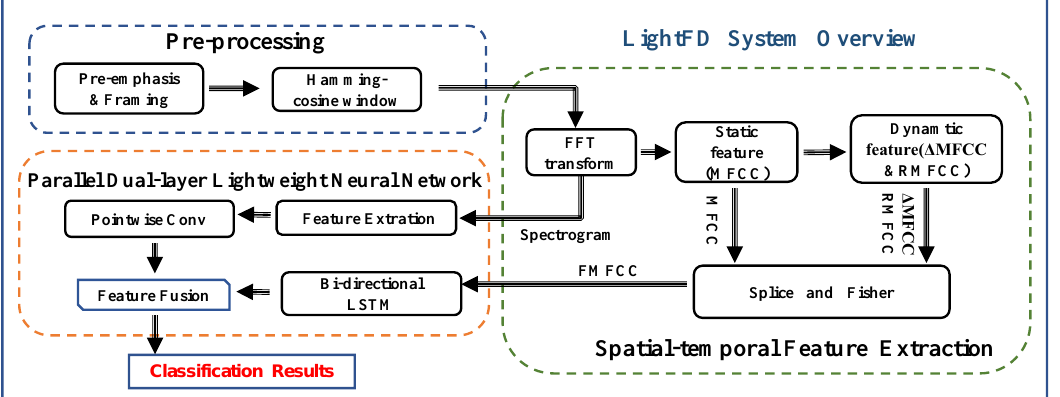
Figure 1. System